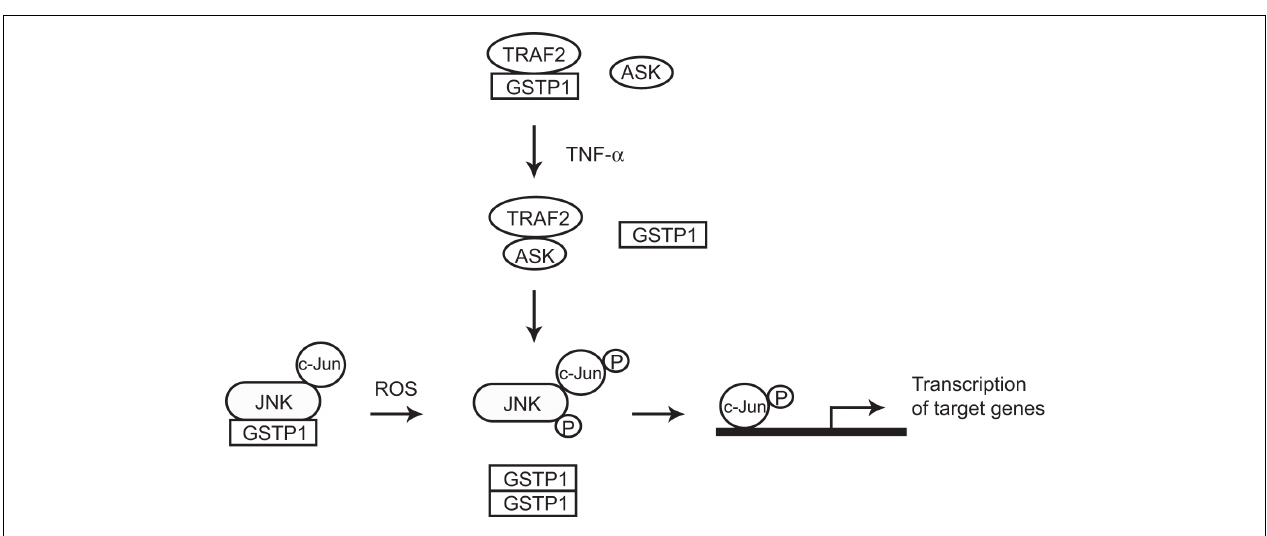
FIGURE 2 | Cartoon model of how GSTP1–JNK and GSTP1–TRAF2 interactions modulate JNK andTNF- α signaling pathways. In non-stressed cells, GSTP1 form complexes with JNK andTRAF2 respectively. GSTP1–JNK interaction keeps JNK at low activity, while GSTP1–TRAF2